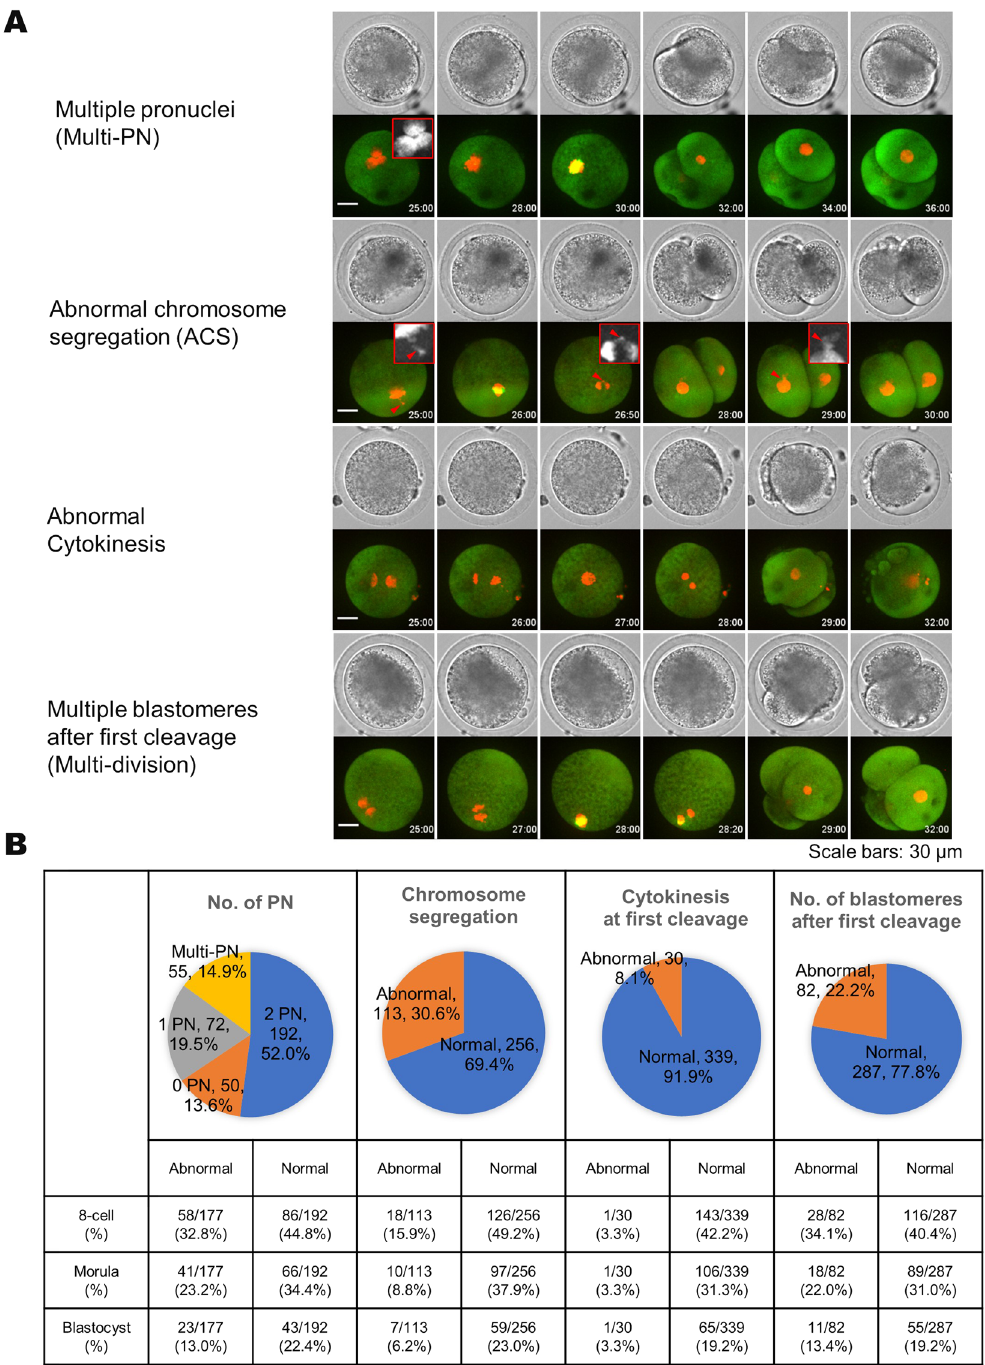
Figure 1. Correlation between abnormal first cleavage and subsequent in vitro development. Pronuclear (PN) number was set to 0 (0 PN), 1 (1 PN), 2 (2 PN), and three or more pronuclei (multi-PN). 0 PN, 1 PN, and multi-PN were defined as abnormal number of pronuclei. Abnormal chromosome segregation (ACS) was defined as the misalignment of a portion of the chromosomes with the metaphase plate, and/or the lagging chromosomes at the anaphase stage. Red arrows show micronuclei-like structures. Abnormal cytokinesis was defined as the occurrence of chromosome segregation, in which the cleavage plane did not appear completely and blastomere number did not increase after chromosome segregation. Abnormal number of blastomeres was defined as three or more blastomeres observed at the end of first cleavage (multi-division). Scale bars are 30 μ m ( A ). Frequency and subsequent developmental competence to 8-cell, morulae, and blastocyst stages in inseminated oocytes with normal and abnormal first cleavage were calculated ( B